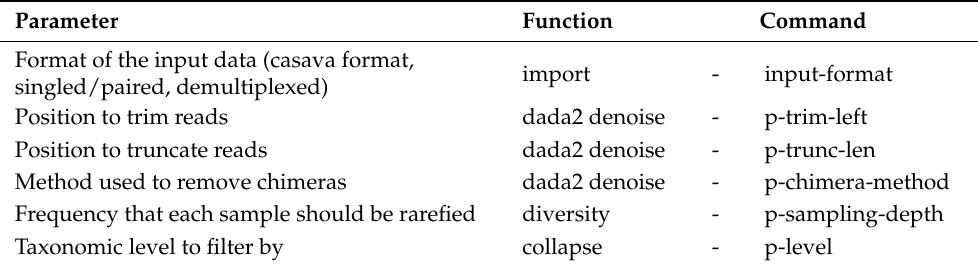
Table 3. Modifiable parameters of our QIIME2